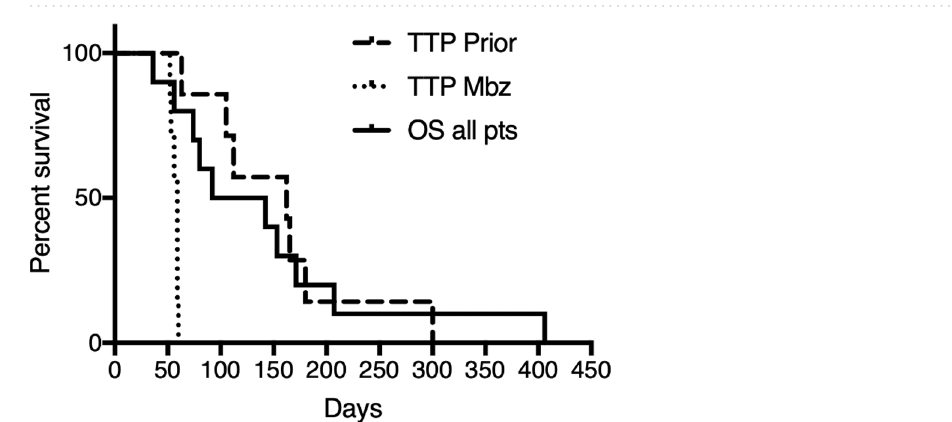
Figure 3. ( a ) CT-scan of abdomen in patient 102 before baseline (left panel), at baseline (middle panel) and first evaluation at week 8 (right panel). This patient fulfilled the criterion for hyperprogressive disease. ( b ) CT-scan of abdomen in patient 109 before baseline (left panel), at baseline (middle panel) and first evaluation at wee 8 (right panel). This patient fulfilled the criterion for hyperprogressive disease.